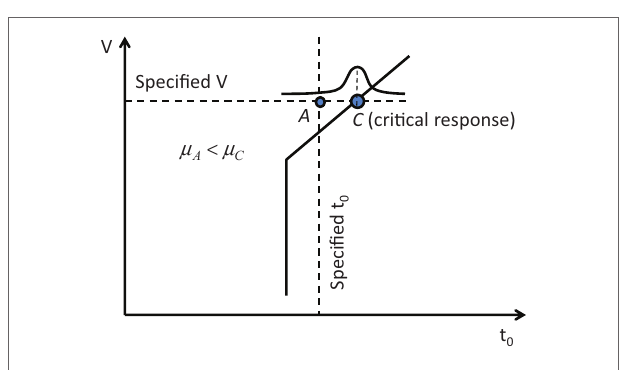
FigUre 15 | schematic diagram of approximate prediction method of response ductility for specified design of stiffness and strength and specified velocity and period of near-fault ground motion input .